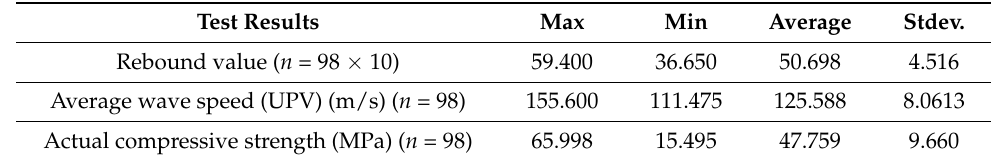
Table 1. Summary of concrete sample test results.